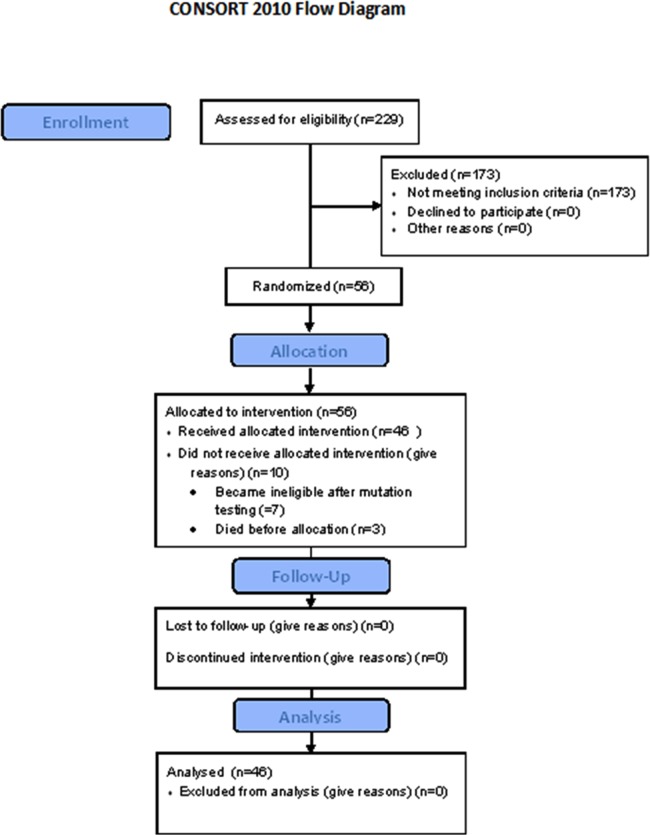
FIELT study flow.